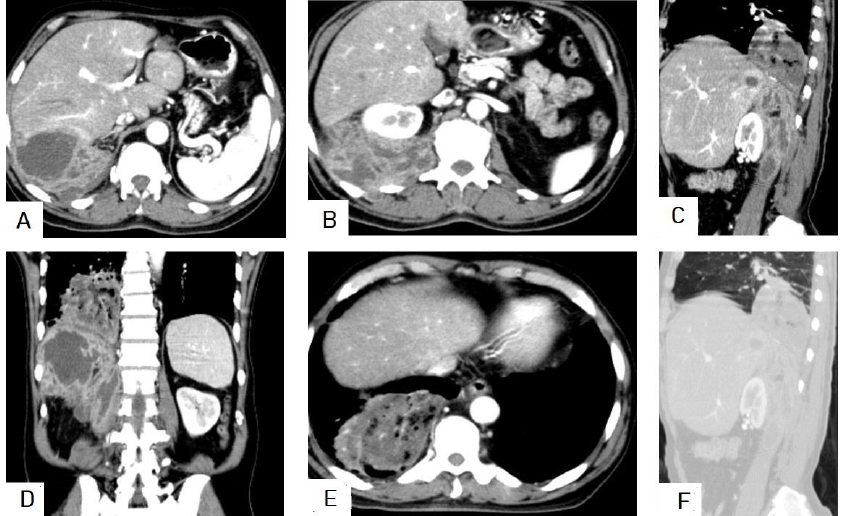
Figure 16. Selected CT images of an 80-year-old man presenting with chest pain, showing about 6.8 × 4 cm multiloculated and peripherally enhanced collection and seeming to arise from the subcap- sular segment-VII of the right lobe of liver with disrupted capsule and exophytic tracking component to subphrenic region into the posterior perinephric and pararenal spaces seen on axial ( A , B ) sec- tions, and extending across the proximal psoas muscle for 7.5 cm caudally seen on sagittal ( C ) and coronal ( D ) sections. Superiorly, the lesion tracks the right hemidiaphragm into the lung, where there is a well-circumscribed mass-like lesion measured at 8.7 × 6.3 × 5 cm with thickened wall with obvious bronchovascular markings seen extended within the lesion in the adjacent lower lobe area seen on sagittal ( C ), coronal ( D ), axial ( E ), and sagittal lung window ( F ) sections. The picture suggests ruptured hepatic hydatid cyst tracking to the retroperitoneaum, psoas muscle, and lung, with superimposed psoas abscess